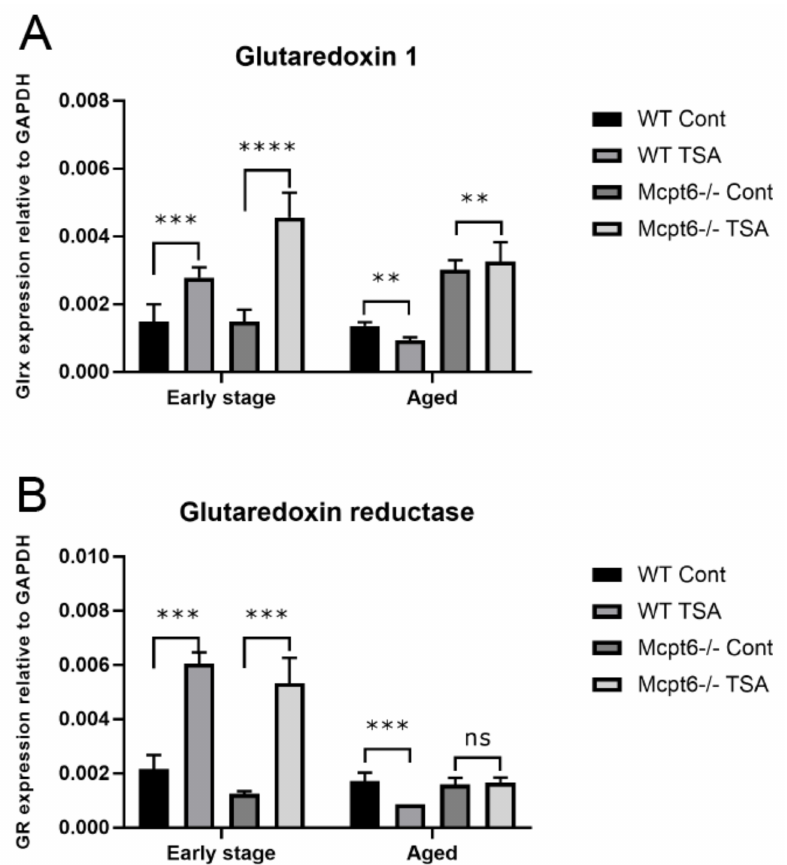
Figure 4. The absence of Mpt6 causes aberrant regulation of glutaredoxin 1 (Grx1) and glutathione reductase (GR) in MCs exposed to TSA. WT and Mcpt6 − / − MCs (early stage and aged) were cultured ± TSA (see legend to Figure 2). Total RNA was isolated and was subjected to qPCR analysis for expression of ( A ) Glutaredoxin 1 (Grx1) and ( B ) Glutaredoxin reductase (GR). Expression of genes was evaluated relative to GAPDH. Note that aged WT cells respond to TSA by downregulated expression of Trx1 and TR, whereas aged Mcpt6 − / − cells were either refractory (GR) or showed upregulated expression (Grx1) in response to TSA. Data are presented as mean values ± SEM, pooled from three di ff erent experiments, analyzed with Sidaks multiple comparison test or by Two-way ANOVA. *** p ≤ 0.001, ** p < 0.005. Cont, vehicle